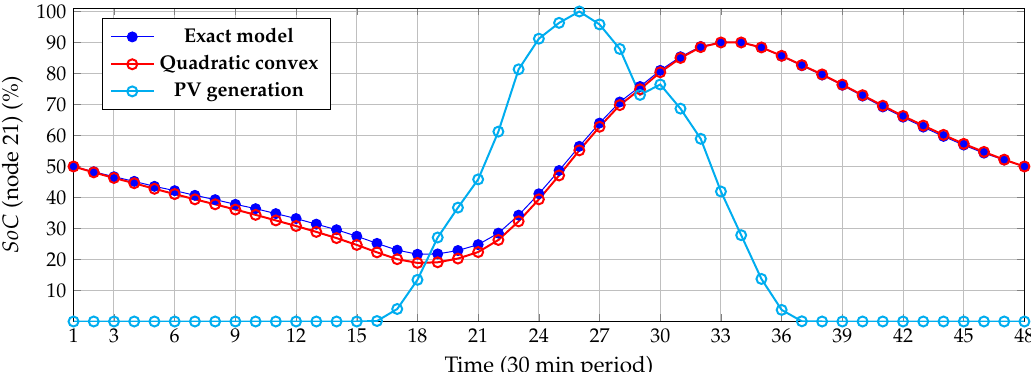
Figure 6. Behavior of the state-of-charge at node 21 for the exact MINLP and the proposed MIQC model compared with the PV generation in the same